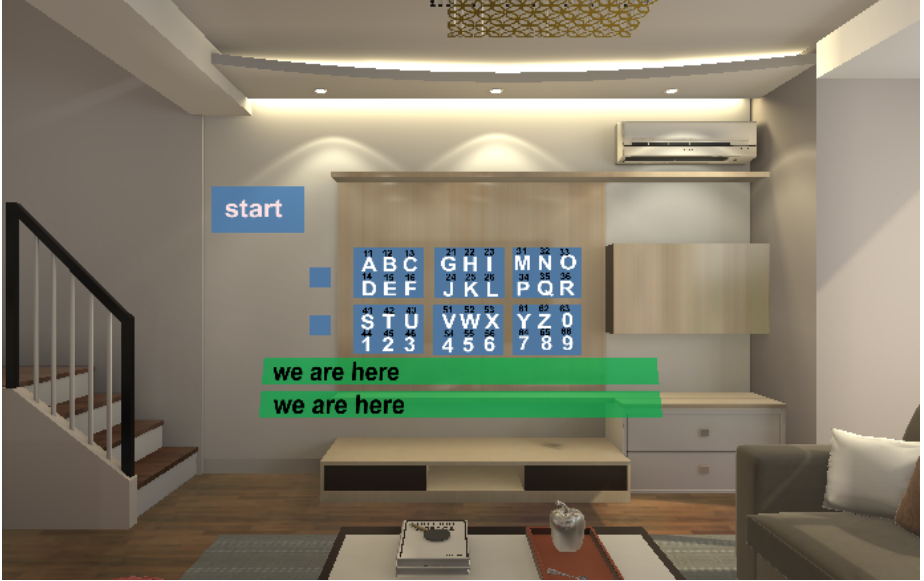
Figure 10. The part of experimental scenario in the